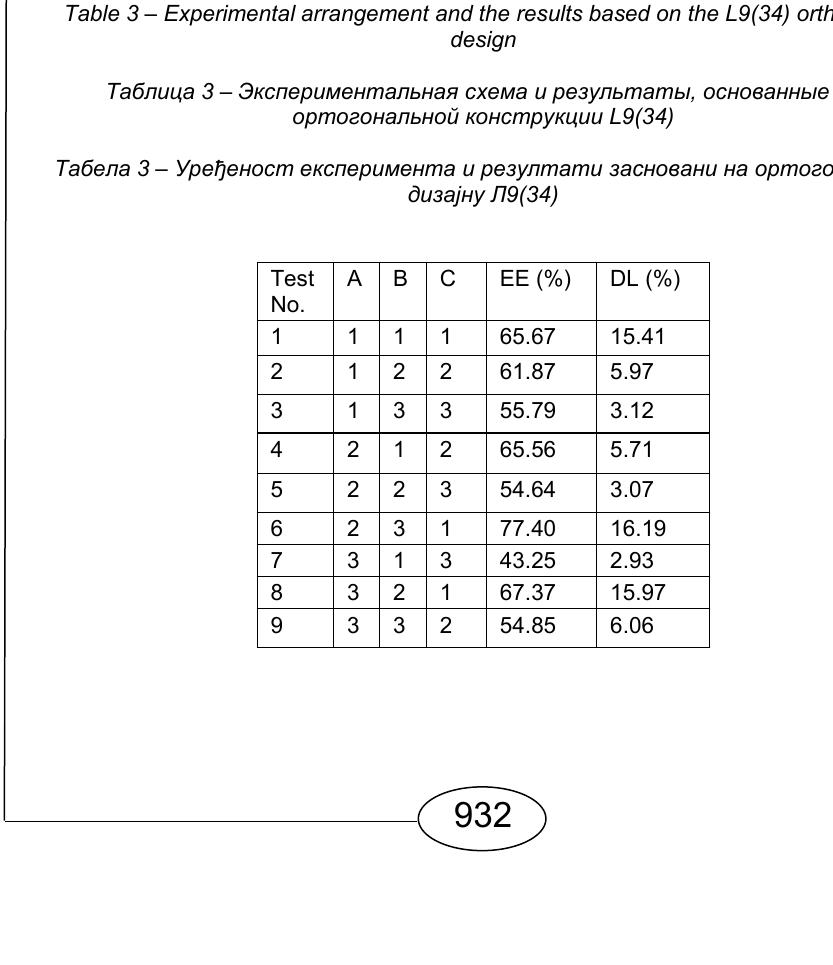
Table 3 – Experimental arrangement and the results based on the L9(34) orthogonal